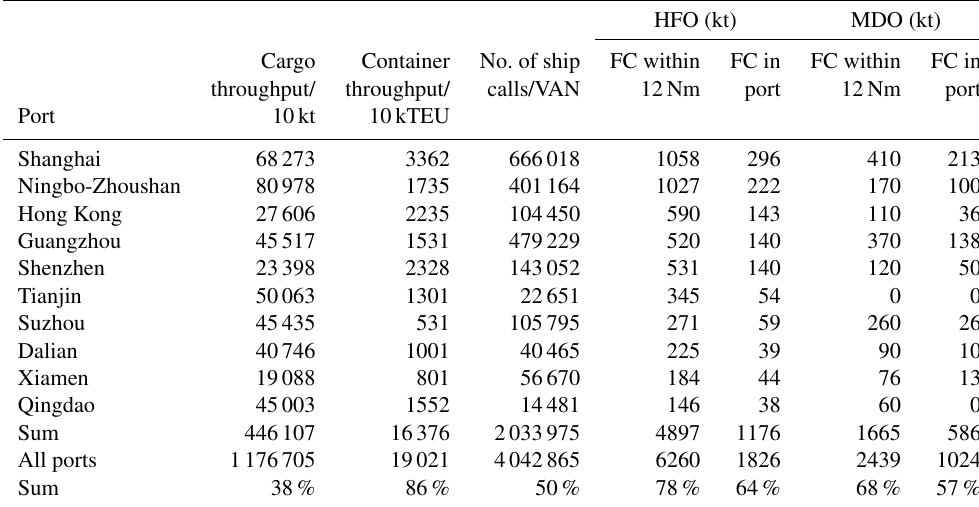
Table 7. Port activity and fuel consumption in the top 10 ports in